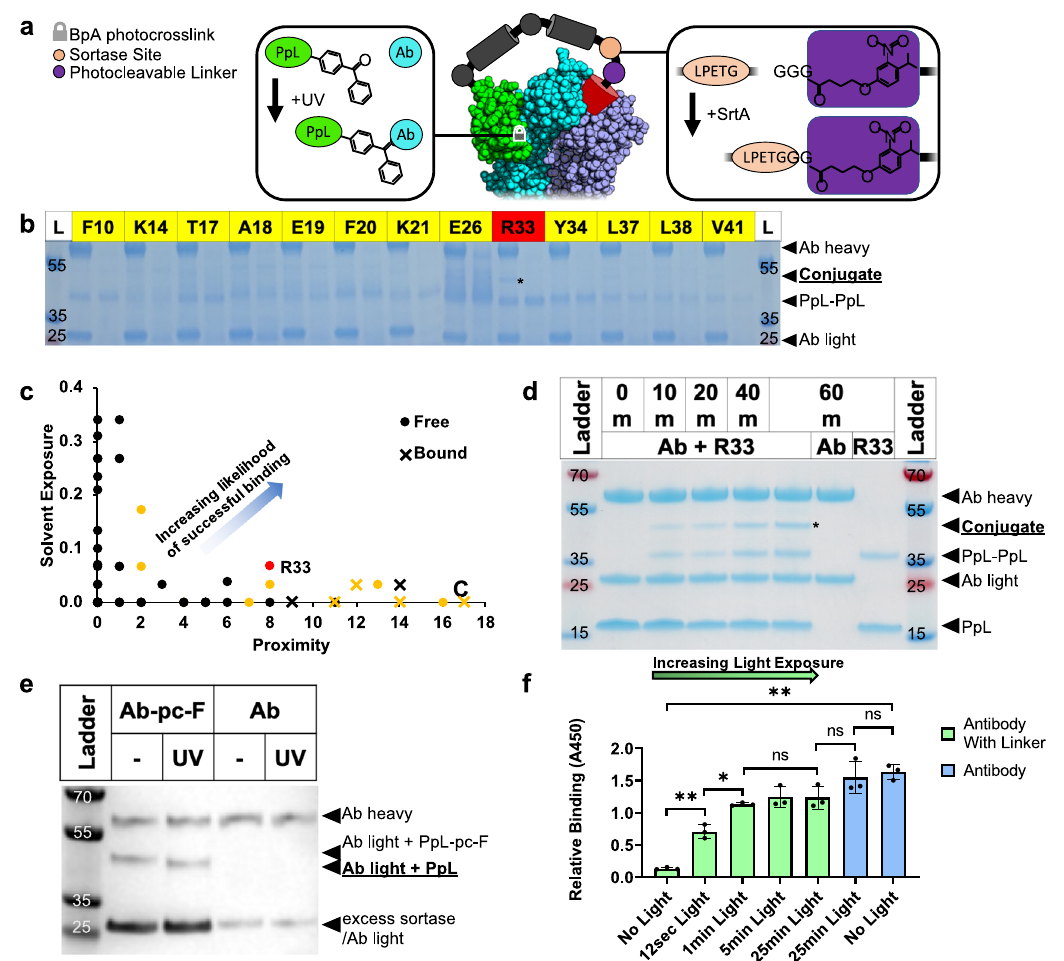
Fig. 2 Successful photoconjugation of PpL to an antibody light chain, and successful blocking of an anti-FLAG antibody followed by light activation. a Different locations were chosen on PpL based on the crystal structure (PDB 1 mhh) to introduce BpA. b A reducing SDS-PAGE gel with 50 µ M of each PpL mutant irradiated with 1 µ M mouse anti-CD3 antibody shows a photoconjugated product between the light chain and PpL (*) only with the R33BpA location, shown in red. Other tested locations are shown in yellow. All gels are labeled with a mass ladder control in kDa. c Graph showing each amino acid in PpL with the solvent exposure level and number of antibody carbons that are within 1 nm. The higher the solvent exposure and the higher the number of proximal carbons the more likely the amino acid was to be a successful candidate for modi fi cation with BpA. Yellow shows which amino acids were modi fi ed and red shows amino acid R33 which was ultimately successful with a high surface exposure and number of proximal carbons. The amino acids are also labeled as “ Free ” or “ Bound ” , based on a 0.35 nm distance cut-off between the PpL sidechain and antibody atoms. d Reducing SDS-PAGE gel showing 100 µ M of PpL-R33BpA (R33) with 4 µ M mouse anti-CD3 antibody (Ab) irradiated under 360 nm light for the time indicated. PpL-R33BpA photoconjugated to the light chain is indicated with (*). e The R33BpA mutant with the linker arm discussed above was photoconjugated to the anti-FLAG antibody and then attached via sortase to a photocleavable blocking peptide. Light exposure for 10 min lead to photocleavage and loss of the blocking peptide. f The anti-FLAG antibody alone or modi fi ed with the photocleavable blocking peptide (as in e ), was treated with 365 nm light for the indicated time, then diluted to 10 nM and analyzed via ELISA for binding ( n = 3). The tethered blocking peptide successfully reduced the binding ef fi ciency of the anti-FLAG antibody to its target and was removed with brief light exposure, leading to activation of antibody binding. ** P < 0.01 and * P < 0.05 by Welch ’ s t - test (two-sided). Bar height shows data average. Error bars are standard